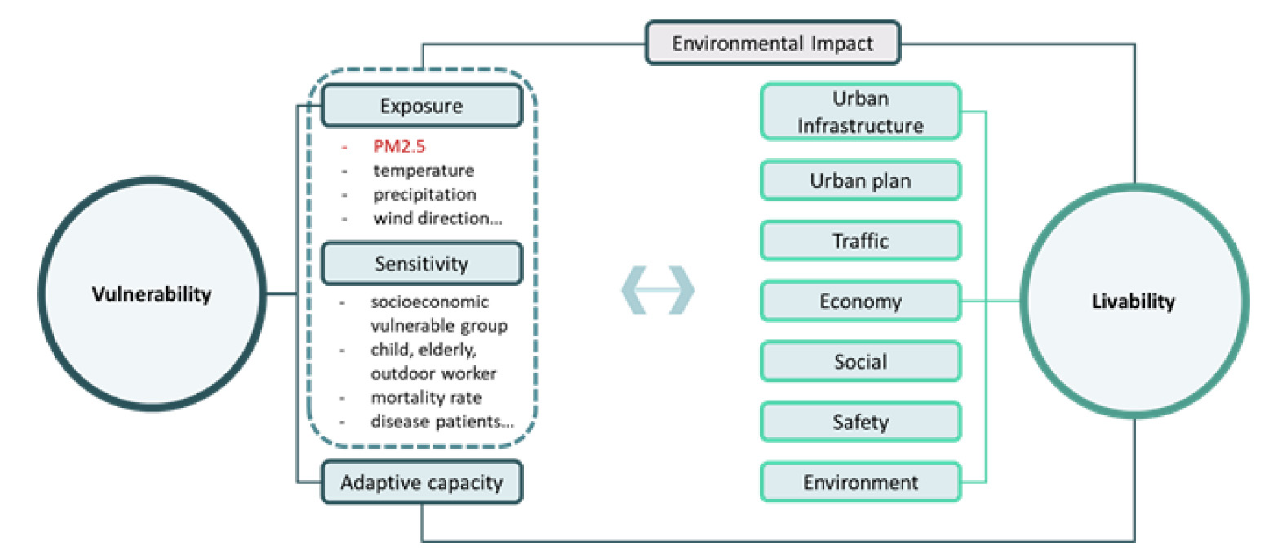
Figure 1. Conceptual diagram of livability measurement considering PM 2.5 vulnerability .